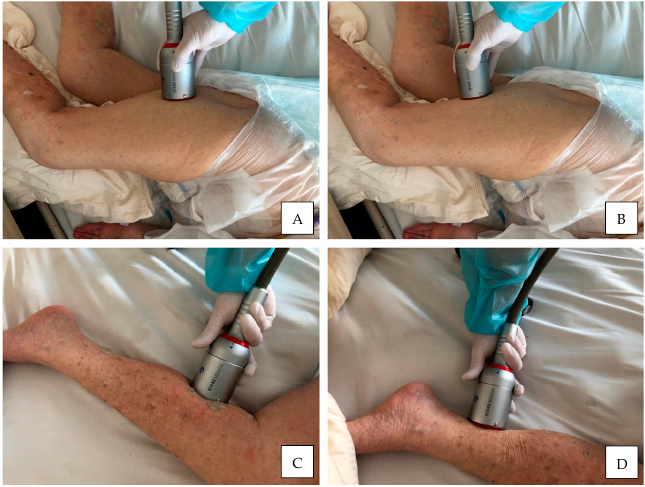
Figure 3. An exemplary methodology of fSWT application for the lower limb muscles. A and B , treatment session deliv- ered to the hip extensors; C and D , treatment session delivered to the ankle plantar flexors. In terms of methodological quality of analyzed studies using ESWT for spastic LL muscles, the mean PEDro score was 4.73 indicating the level C of recommendation ac- cordingly with the NICE guidelines. The results of methodological quality assessment with PEDro score and level of evidence with NICE tool for studies using ESWT in treat- ment of lower limb spasticity are presented in Table 6.